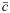
Scatter plots involving forest and bar chart characteristics.r denotes the Pearson correlation coefficient. “***” indicates p values < 0.001 and “*” indicates p values between 0.01 and 0.05. Black–low thinning, red–crown thinning. c¯–mean conformity number, vd−coefficient of variation of stem diameters, kd−skewness of the empirical diameter distribution, P0 –proportion of trees marked “0” by all raters, Pm−proportion of trees marked in the 20% highest classes of the marking bar chart, B¯ - mean ratio of the proportion of number of trees marked with “1” and the proportion of basal area of these trees, see Section “Statistical measures of interrater agreement”.